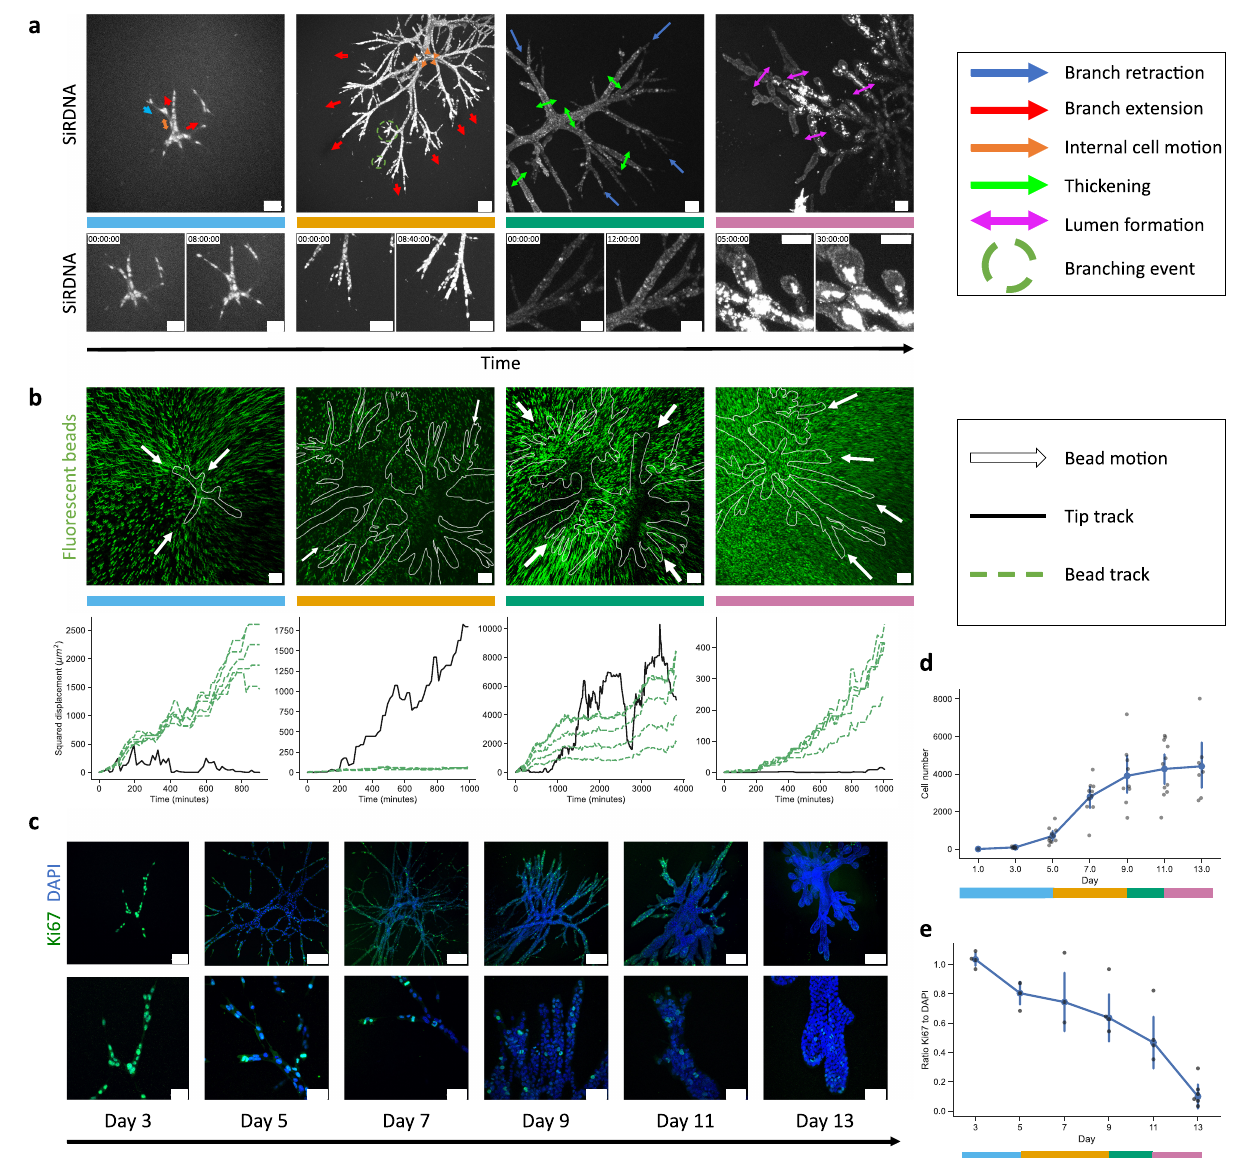
Fig. 2 | Collagen-grown organoids go through different phases of develop- ment. Developmentphasesaredenotedbycolorbarswhichfollowthecolorcode presented in Fig. 1. Blue: onset, orange: extension, green: thickening, pink: lumen formation.Organoidsshownherearegrownincollagen. a Cellularmotionpatterns observed with live confocal imaging for each development phase ( n =66 orga- noids).CellnucleiarestainedwithSiRDNA(white).Scalebars:100 µ m.Fromleftto right: Day 4 SUM projection, and Day 7, Day 10, Day 13 maximum projections. b Top, time-projections of fl uorescent beads (green, maximum projections) tra- jectories at different time points, indicating the deformation fi eld around the organoids. Organoids are outlined in white and white arrows denote the direction of bead motion. From left to right: Day 4 – 5, Day 7 – 8, Day 8 – 9, Day 13 – 14. Scale